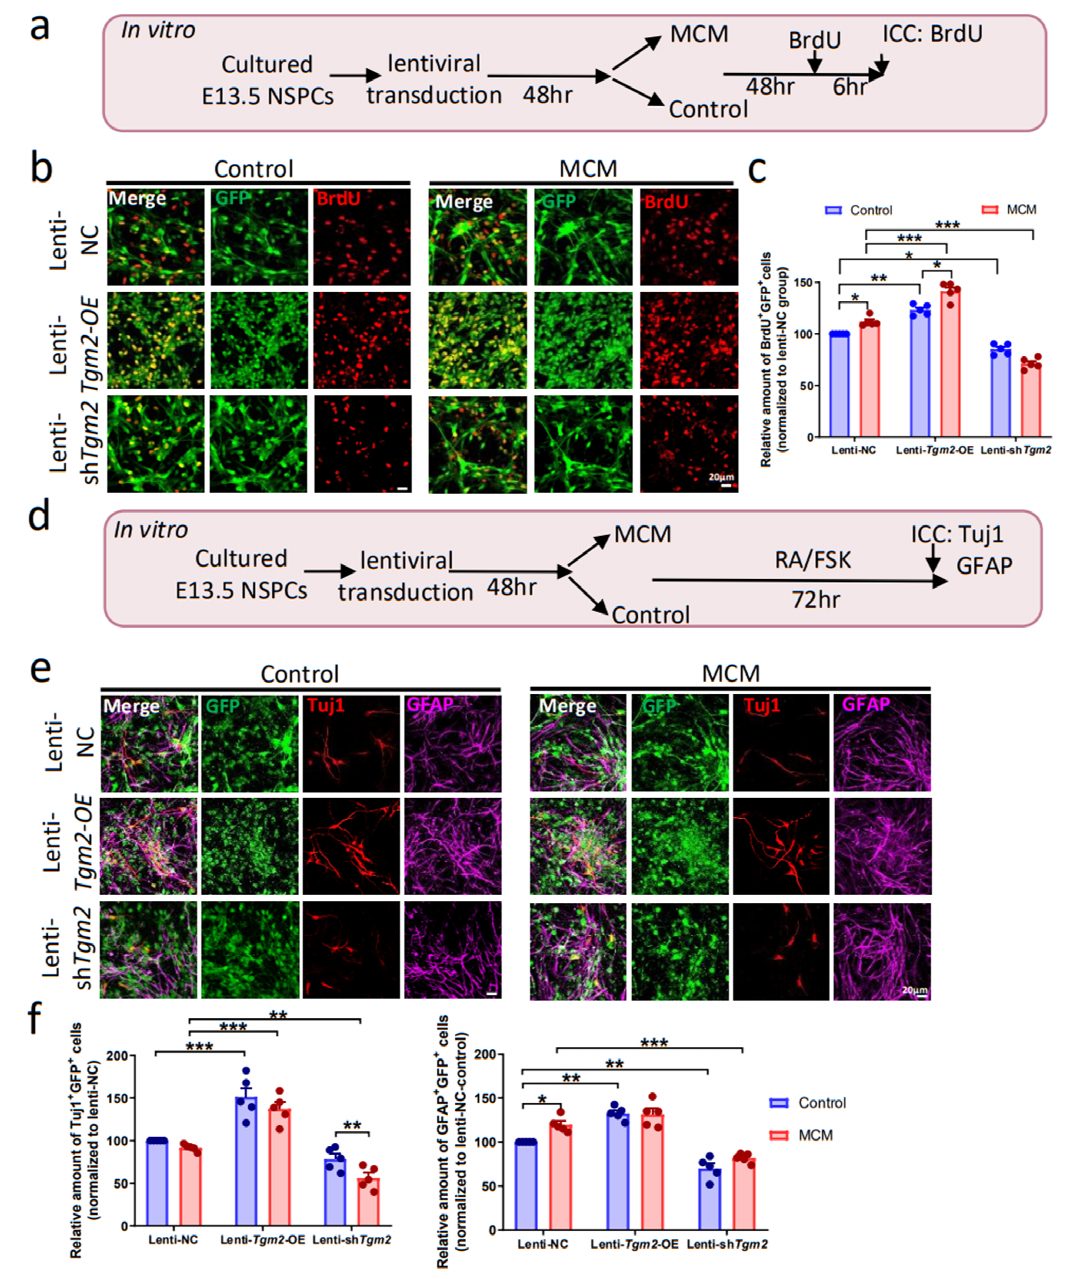
Figure 3. TGM2 promotes neurogenesis of NSPCs in in vitro. ( a ) Schematic illustration for analyzing proliferation of NSPCs in vitro. Cultured E13.5 NSPCs were transduced by lenti-NC, lenti- Tgm2 -OE, or lenti-sh Tgm2 for 48 h, then treated with control medium or microglial conditioned medium (MCM) for 48 h, followed by BrdU labeling. The ratio of BrdU + GFP + /GFP + cells was quantified. ( b , c ) Representative images ( b ) and quantification ( c ) of BrdU immunostaining of lenti-NC, lenti- Tgm2 -OE or lenti-sh Tgm2 -transduced NSPCs. Scale bars: 20 μ m. ( d ) Schematic illustration for analyzing differentiation of NSPCs in vitro. Cultured E13.5 NSPCs were transduced by lenti-NC, lenti- Tgm2 -OE, or lenti-sh Tgm2 for 48 h, then switched to differentiation medium treated with control medium or MCM for 48 h. The ratio of Tuj1 + GFP + /GFP + and GFAP + GFP + /GFP + cells were quantified. ( e , f ) Representative images ( e ) and quantification ( f ) of Tuj1 and GFAP immunostaining of the differentiation of NSPCs which were transduced with lenti-NC, lenti- Tgm2 -OE or lenti-sh Tgm2 virus. Scale bars: 20 µ m. n = 5 cultures. Data are represented as means ± SEM; two-way ANOVA, * p < 0.05, ** p < 0.01, *** p <